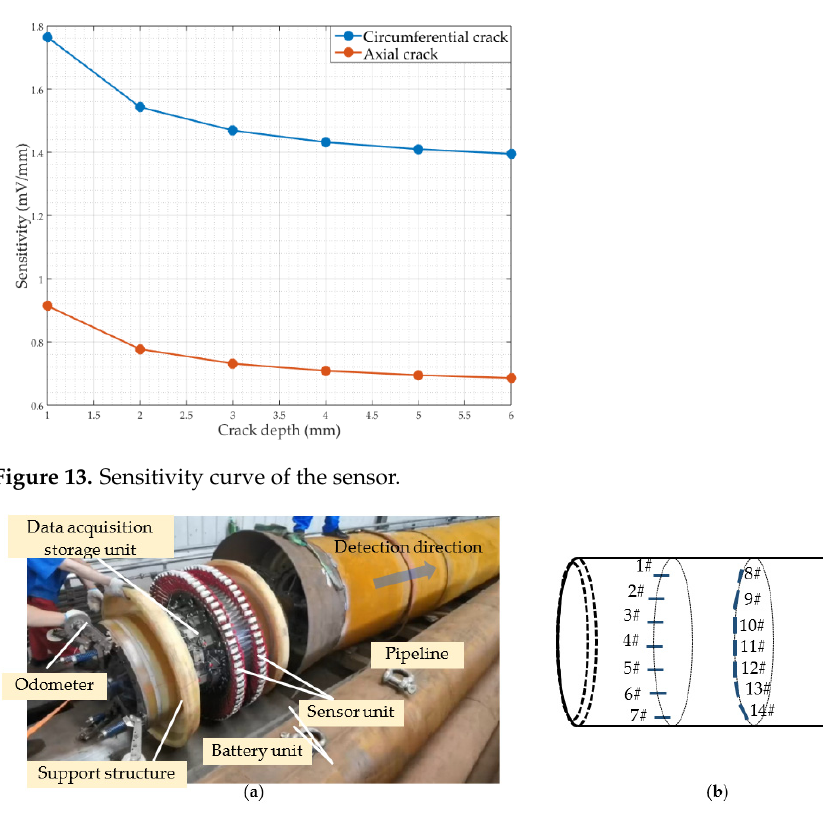
Figure 14. ( a ) Pipeline pulling test; ( b ) diagram of crack distribution. Table 3. Dimensional parameters of cracks.